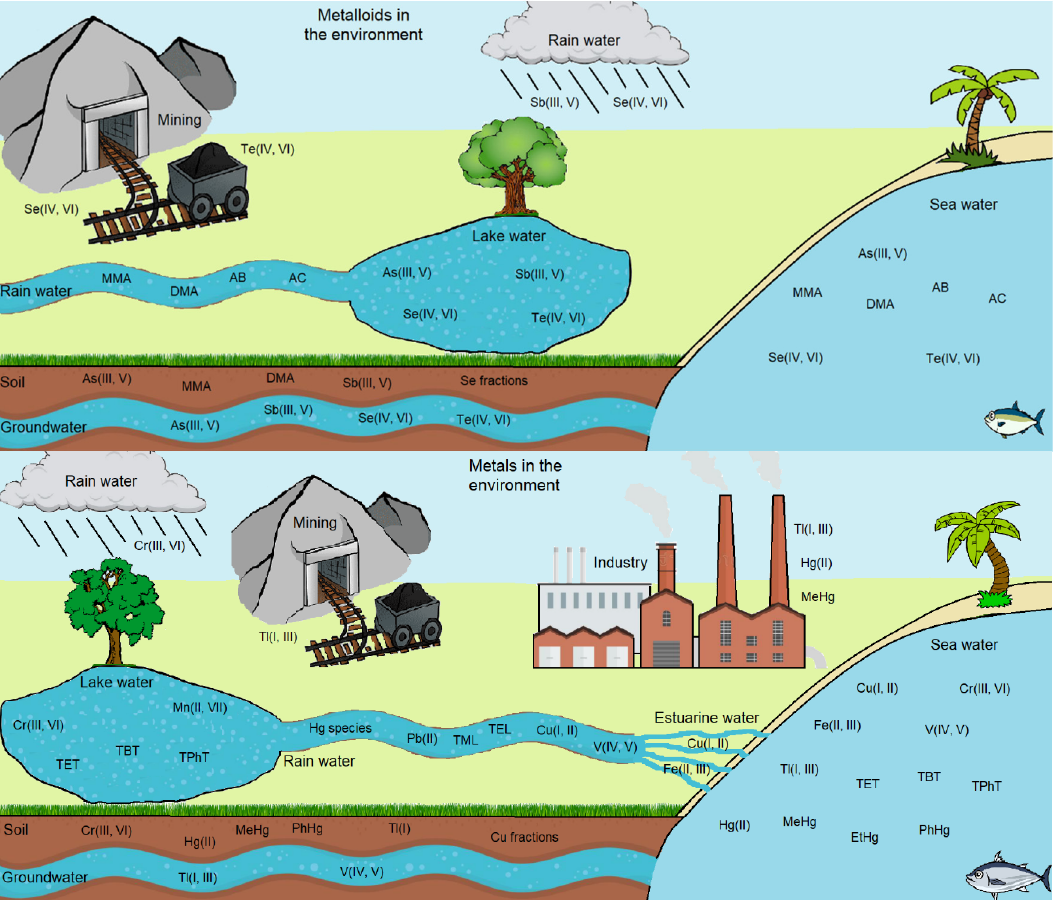
Figure 1. Metal and metalloid species distribution in diverse environmental and industrial compartments. AB: arsenobetaine, AC: arsenocholine, DMA: dimethylarsinic acid, EtHg: ethylmercury, MeHg: methylmercury, MMA: monomethylarsonic acid, PhHg: phenylmercury, TBT: tributyltin, TEL: tetraethyl lead, TET: triethyltin, TML: tetramethyl lead, TPhT: triphenyltin.